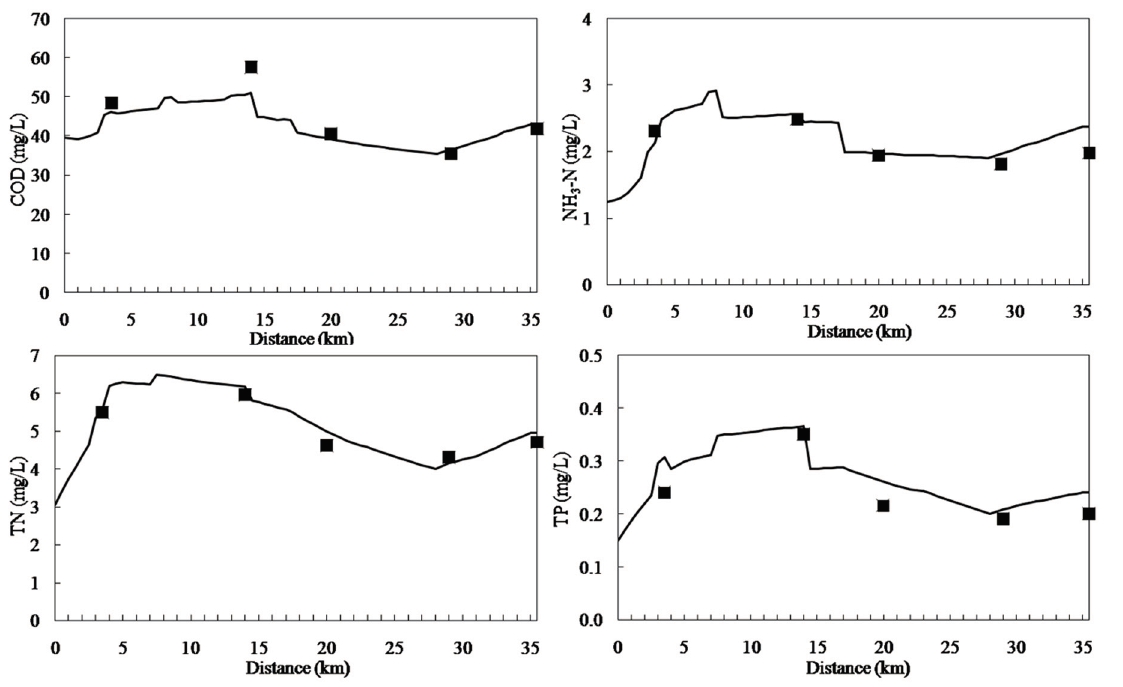
Figure 4. Water quality validation results for the Wujin